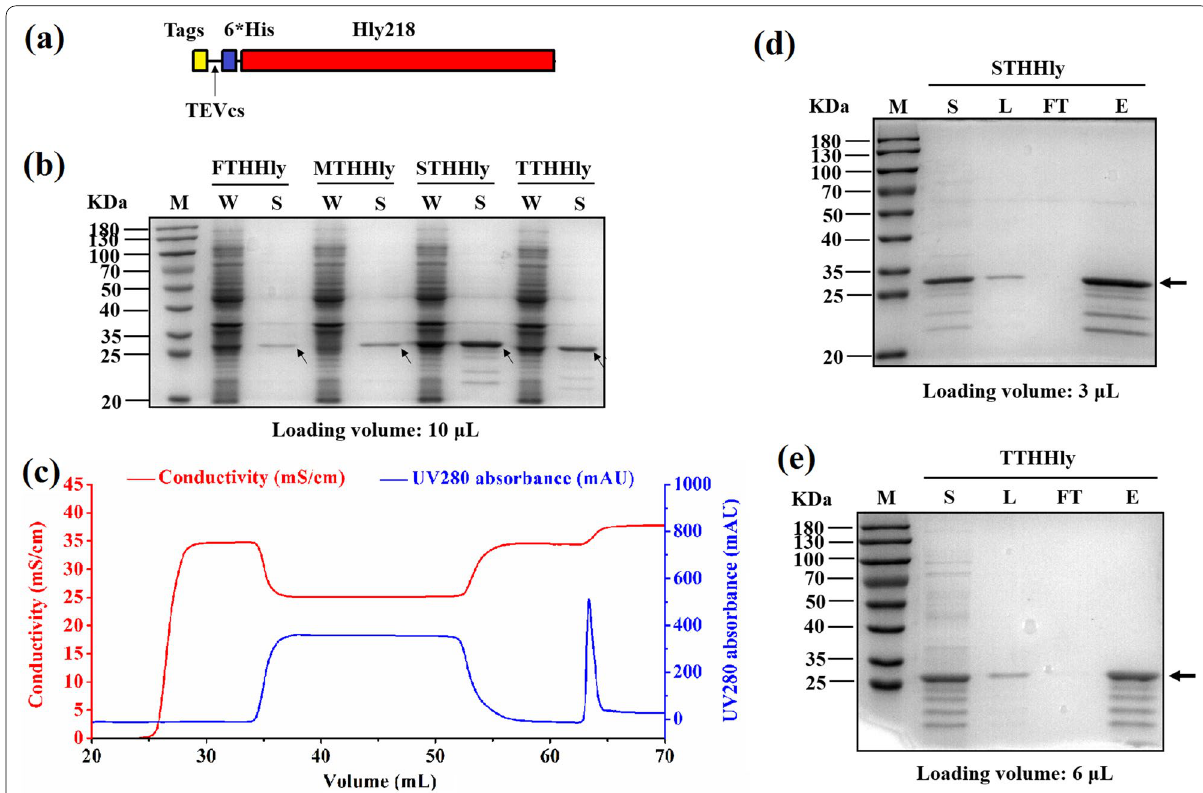
Fig. 4 Secretory expression and purification of the tags fusion protein. a Plasmid pET-Tag-THHly. b Secretory expression of the Tag-THHly fusion proteins. W whole-cell lysate, S supernatant. c Purification curve of STHHly. d , e Purification of STHHly ( d ) and TTHHly ( e ). S supernatant, L loading sample, FT flow through, E eluent. The arrows indicate Tag-THHly in b , STHHly in d , and TTHHly in